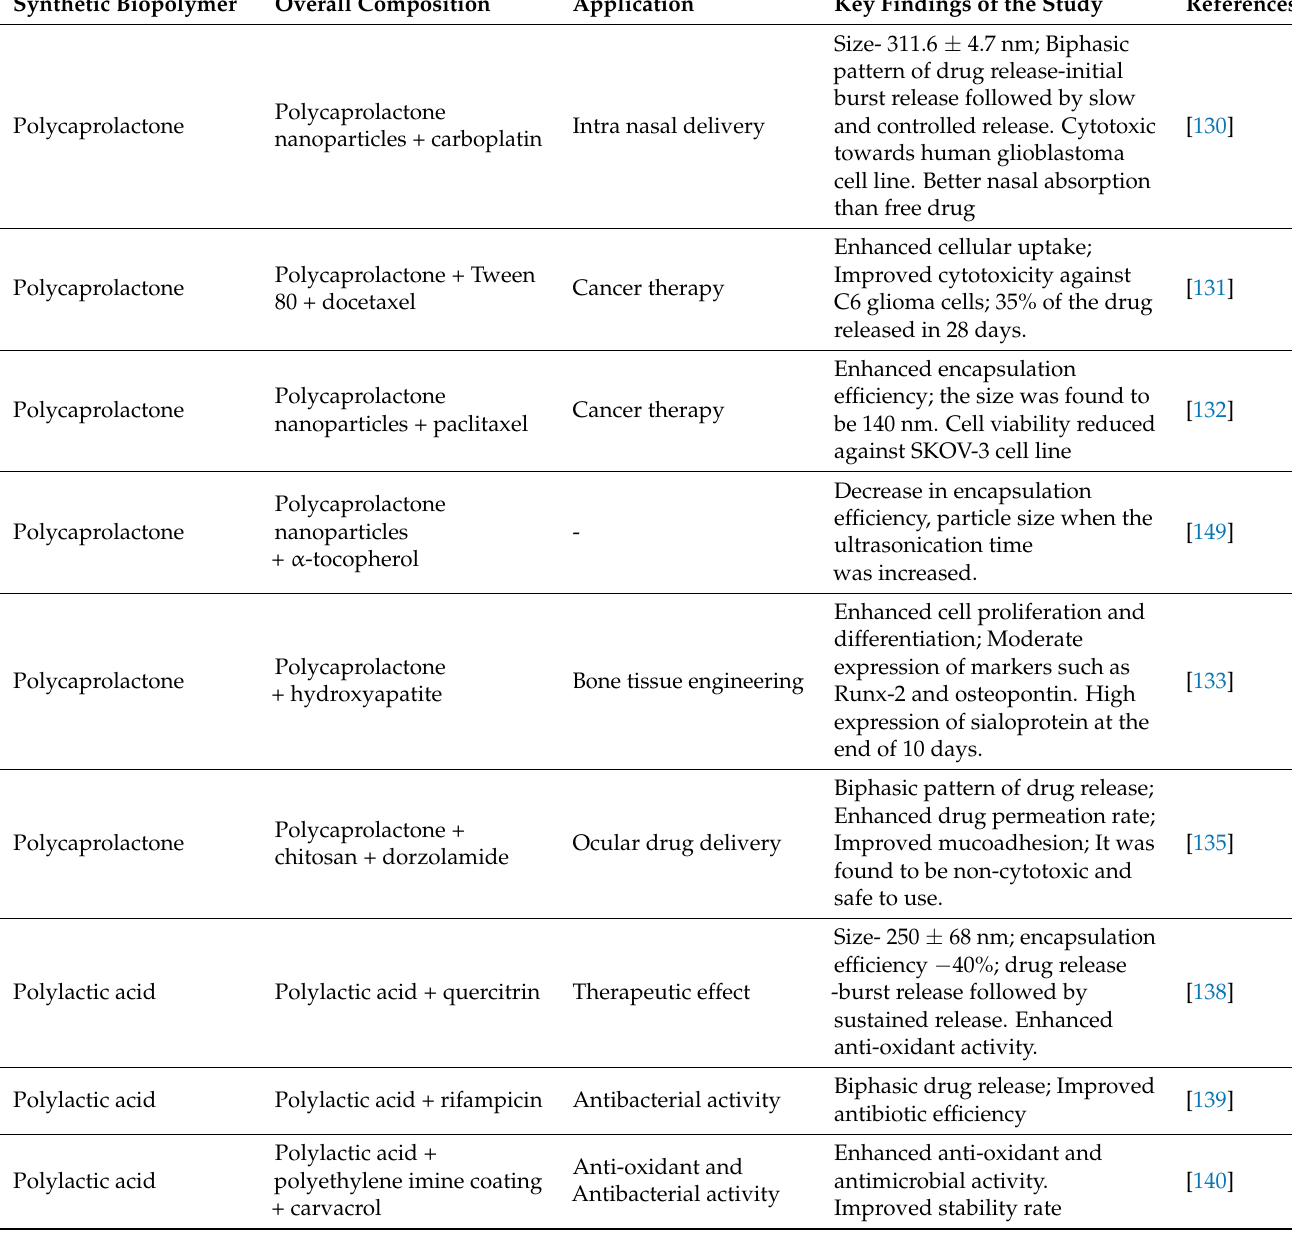
Table 4. Summary of synthetic bio polymeric